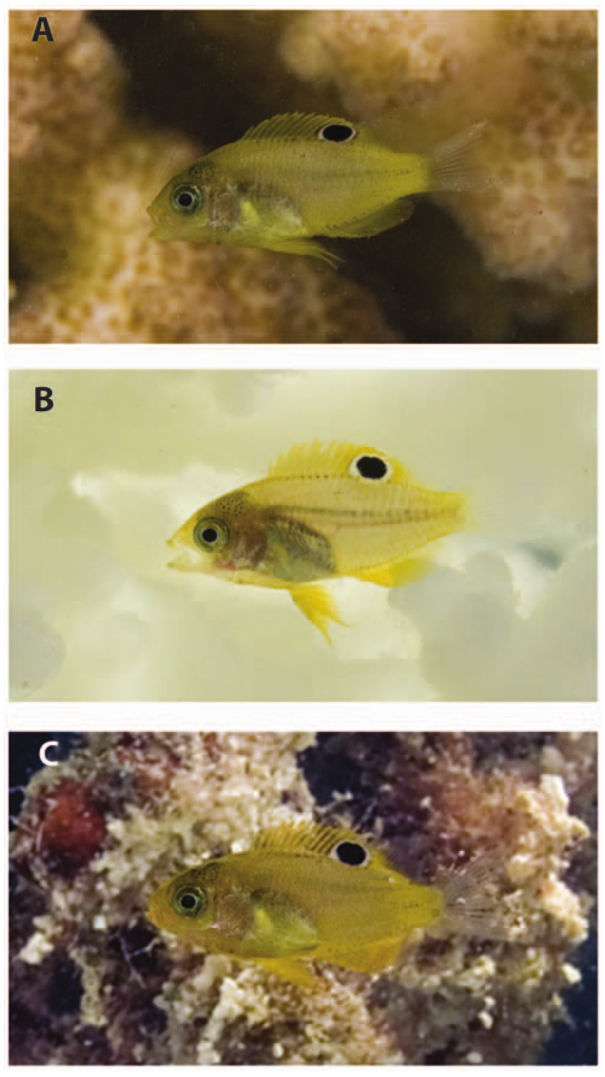
Figure 4. Typical contrast of recently settled Pomacentrus amboinensis against 3 common habitat backgrounds: a) live Pocillopora damicornis , b) thermally bleached P. damicornis and c) dead P. damicornis